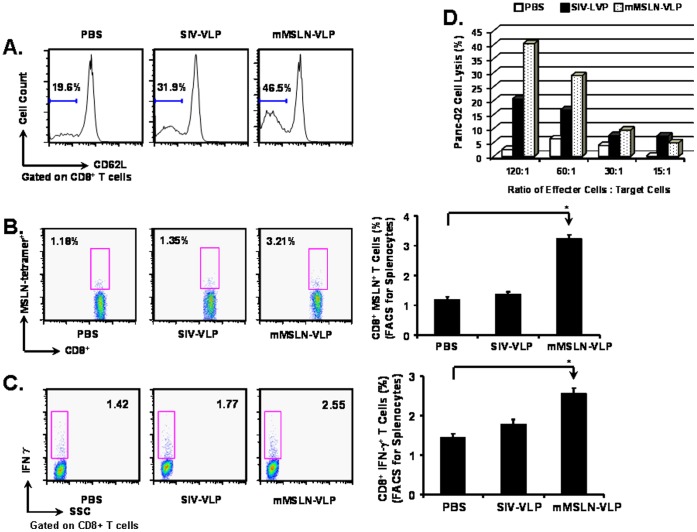
MSLN-specific functional CD8+ T cells in the mMSLN-VLPs immunized mice group.At 17th day after tumor implantation and after one time VLP vaccination at day 3, mice were sacrificed for immune response analysis. FACSCalibur was used to acquire and FlowJo software was used to analyze the data. A). General CD8+ T cell activation in the PBS control group and the VLPs immunized mice groups. Cells were gated on CD8+ T cells, T cell activation marker CD62L expression were shown in the histogram. B). MSLN-specific tetramer+ CD8+ T cells induction. Splenocytes were stained with PE labeled MSLN-specific tetramer. C). MSLN-specific IFN-γ producing CD8+ T cell induction. Splenocytes were re-stimulated with MSLN peptide for 6 h in the presence of Golgi blockage compound in vitro. After fixation and permeabilization, the pre-treated splenocytes were stained by PE labeled anti IFN-γ antibody. D). MSLN-specific CTL induction against Panc02 cells. The splenocytes were re-stimulated in vitro for 6 days in the presence of IL-2. The pre-treated splenocytes were counted and used as effecter cells. Panc 02 cells were used as target cells. Effecter cells and target cells were mixed with various E:T ratio and incubated for 4 h. The percentage of lysis was calculated as: % Cytotoxicity = [(Experimental - Effecter Spontaneous - Target Spontaneous)/(Target Maximum - Target Spontaneous)] × 100. Shown were representative data selected from two independent experiments with five mice per group. (Statistically significances are shown, * indicates p<0.05.).